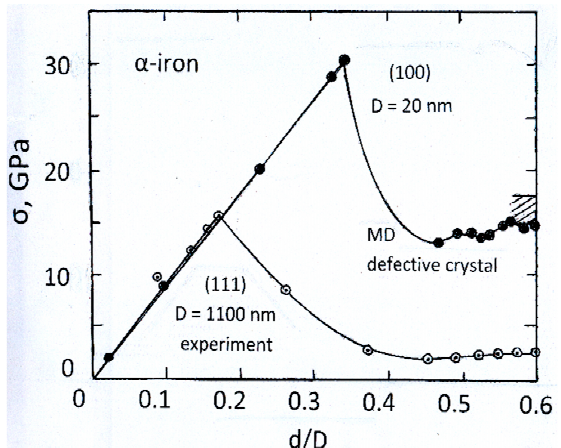
Figure 3. Experimental [11] and simulated [5] nano-indentation stress–strain dependencies calculated for α -iron (111) and (100) crystal surfaces employing different respective D values of 1100 and 20 nm. Also included in Figure 3 are same-type calculations made for a simulated nano-indentation test run by Alhafez et al. [5] on a ‘defective’ α -iron (100) crystal surface. A value of D = 20 nm was